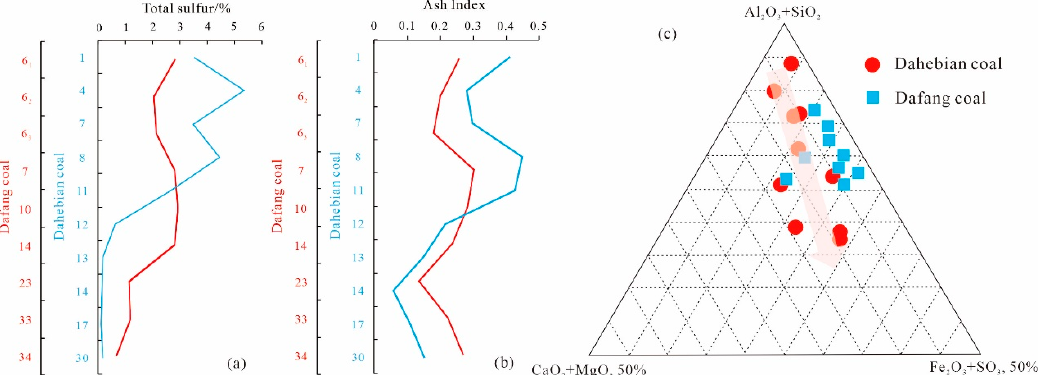
Figure 3. Sedimentary environment indication using different coal qualities parameters. ( a ) Total sulfur; ( b ) Ash index; and ( c ) Triangular diagram of ash